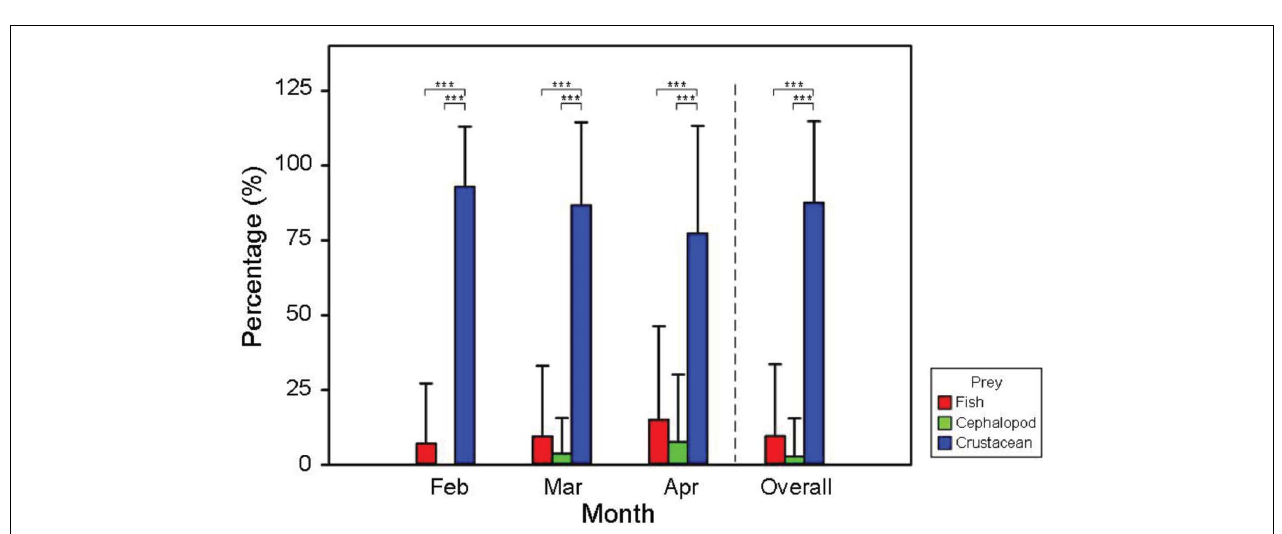
FIGURE 2 | Photographs showing examples of identifiable prey, including fishes ( Dolichopteryx sp., Rhynchohyalus sp., Gymnoscopelus nicholsi , Notophycis marginata , and Micromesistius australis ), cephalopods ( Illex argentinus , Loligo gahi , and Histioteuthis atlantica ), and crustaceans (the Amphipoda, Decapoda, and Euphausiacea orders). The inset scale bars denote 0.5 mm for each